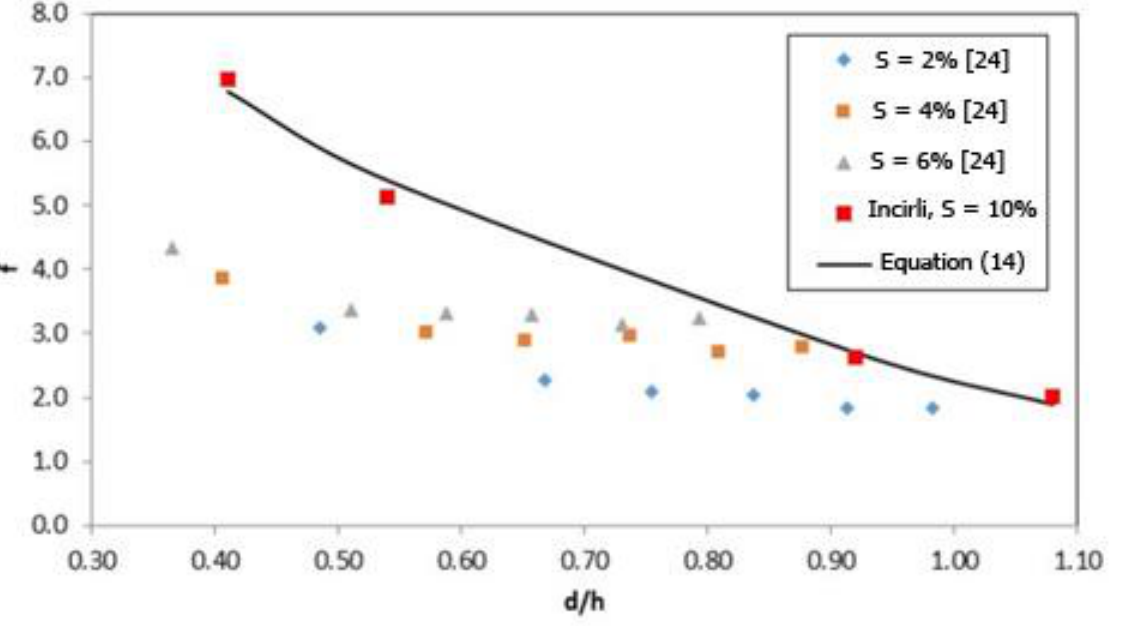
Figure 8. Friction factor versus relative submergence of bristles. The prototype data are compared with the brush-fish-pass physical model data from Kucukali [24].